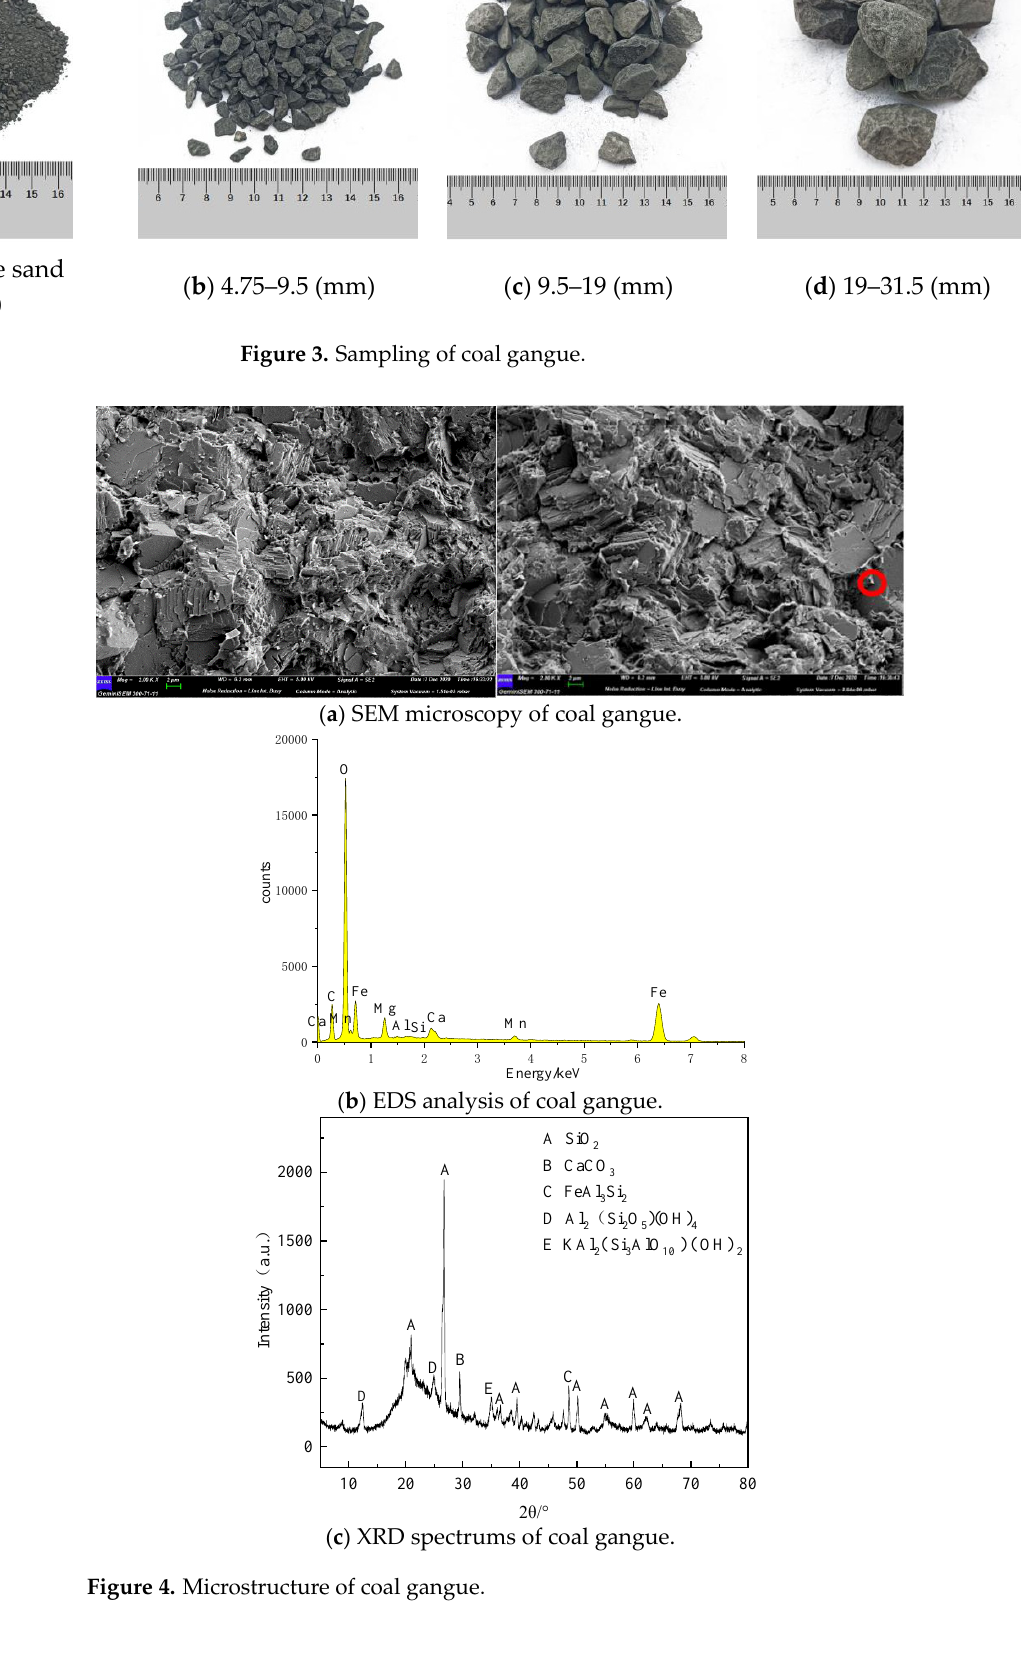
Table 2. Physical and mechanical properties of coal gangue coarse aggregate (wt.%).